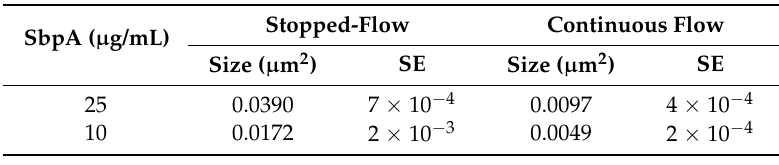
Table 2. SbpA S-layer mean domain dimension values for 10 and 25 µ g/mL concentrations ( N = 50) under both stopped-flow and continuous-flow conditions. The error value (SE) corresponds to the Mean Standard Error.